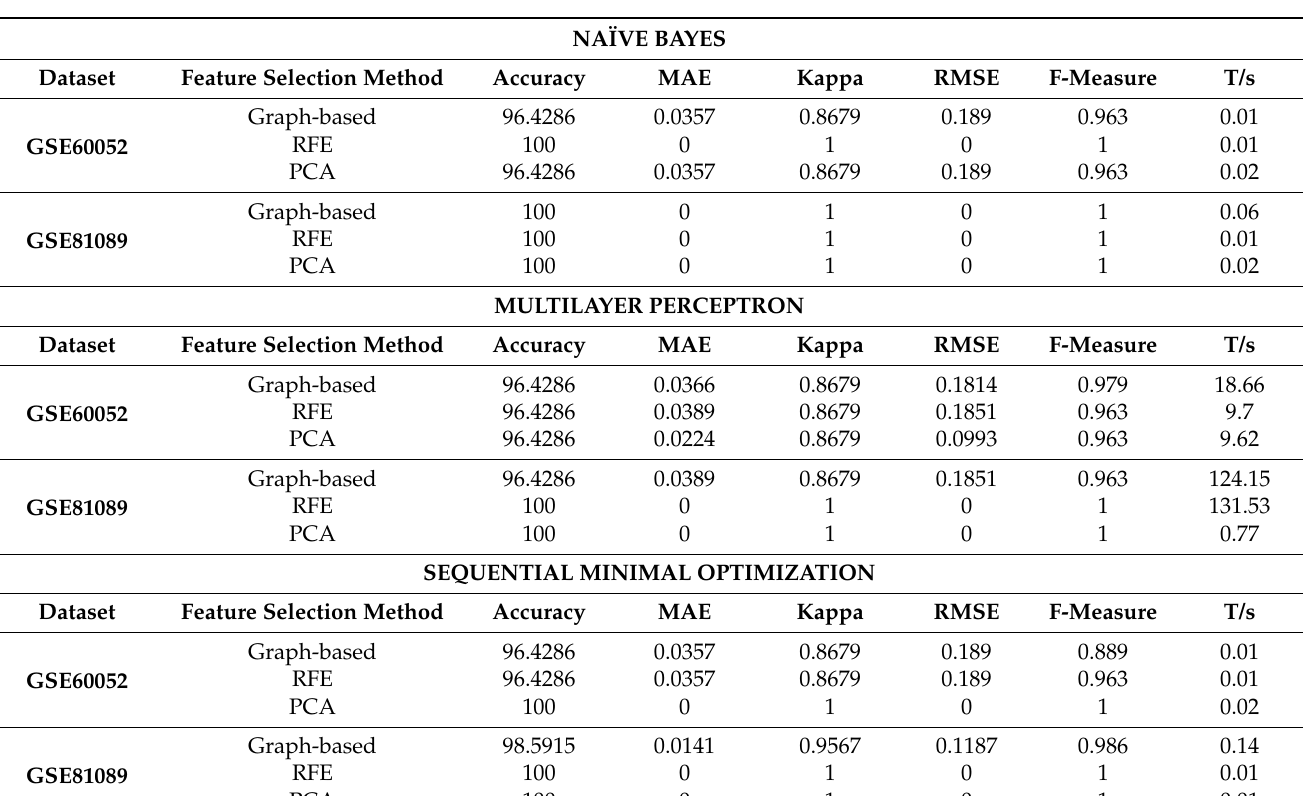
Table 3. Classification results after feature